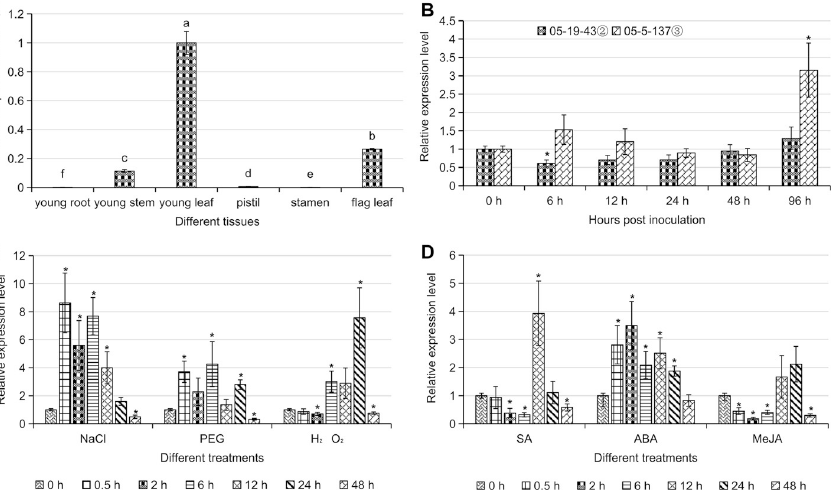
Fig 5. Expression patterns of TaAFR in different wheat tissues and in response to stresses/hormone treatments. (A) Expression profile of TaAFR in different tissues of TcLr15. Different letters indicate significant differences (p < 0.05). (B) Expression patterns of the TaAFR gene in incompatible and compatible combinations of TcLr15/ Puccinia triticina strains 05-19-43 ② and 05-5-137 ③ , respectively. (C) Effect of NaCl, PEG and H 2 O 2 on TaAFR expression in TcLr15 leaves. (D) Effect of SA, ABA and MeJA on TaAFR expression in TcLr15 leaves. To remove the effect of the circadian cycle on TaAFR expression in B, C and D, the relative expression values for TcLr15 leaf control samples, harvested at the same time points as for the various treatments, was subtracted from the relative expression of the treatment samples at the specified harvest times. Relative expression, with the effect of the circadian cycle removed, was then compared to the 0 h untreated control; significant differences (p < 0.05) are marked with an asterisk.